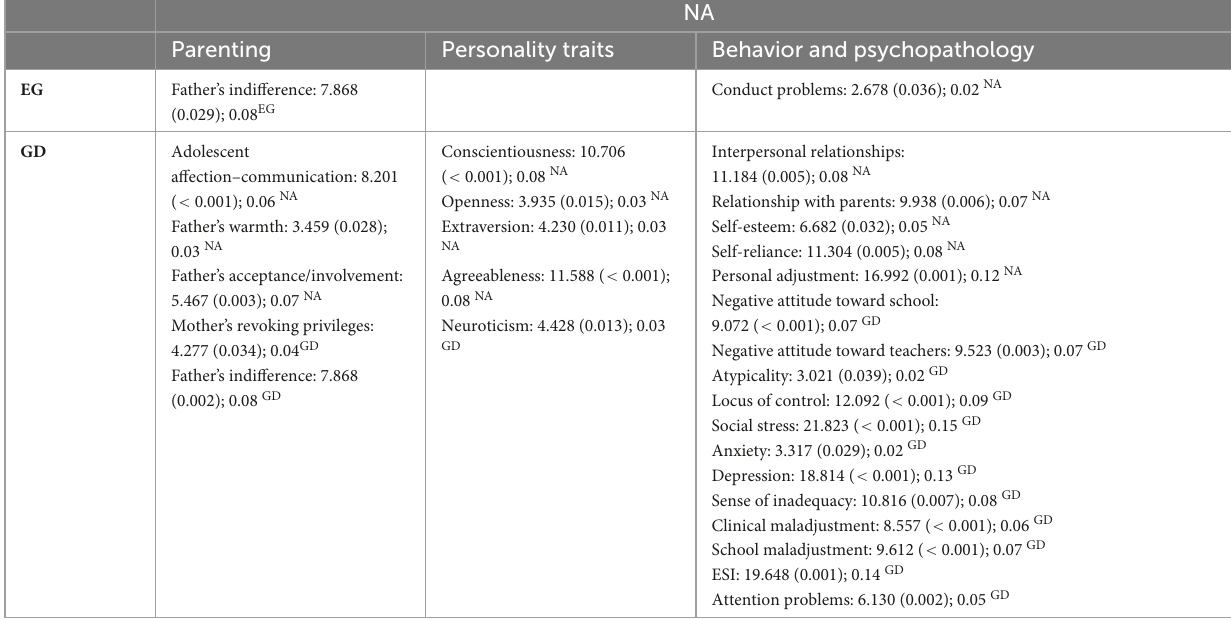
TABLE 4 Differences between the no addiction, Excessive Gaming, and Gaming Disorder groups according to ANOVA analysis (F[p]); ES. NA Parenting Personality traits Behavior and